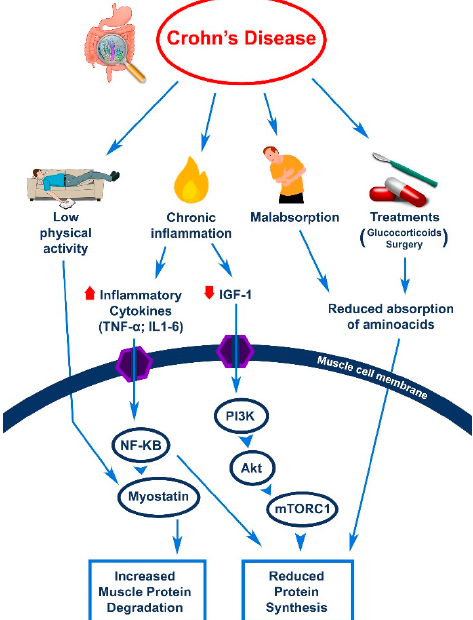
Figure 1. Different mechanisms are involved in the pathogenesis of sarcopenia in patients with CD. The combined effect of inflammatory cytokines (e.g., TNF- α , IL-6) in determining increased muscle protein degradation, through NF-KB and increased Myostatin activity, are here summarized. By reducing IGF-1 and its related intracellular signal pathway, along with the decreased amino acid absorption also due to therapeutic interventions, chronic inflammation determines a diminished protein synthesis. Abbreviations: TNF- α : tumor necrosis factor Alfa; IL-6: interleukin 6; PI3K: phosphatidylinositol-3-kinase; AKT: protein kinase B; mTORC1: mammalian target of rapamycin complex; IGF-1: Insulin-Like Growth Factor-1; NF-KB: Nuclear Factor Kappa B.